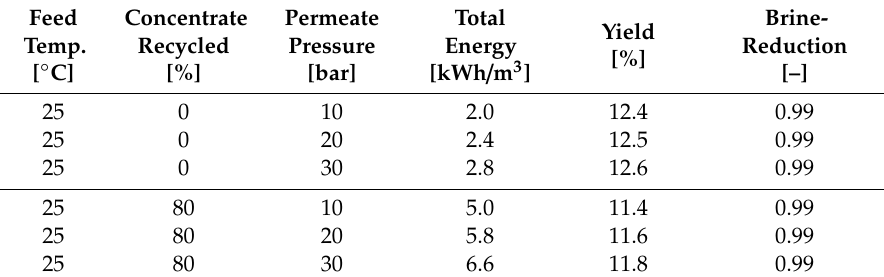
Table 14. Optimized results of SW30XLE-440i membrane at 25 ◦ C.